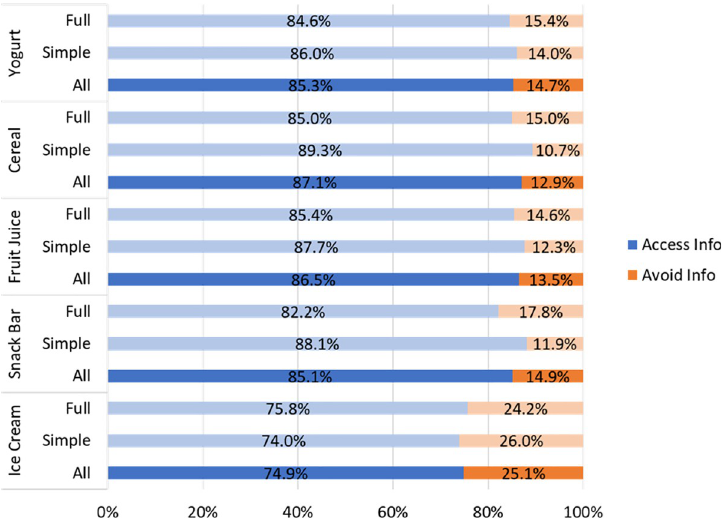
Fig 3. Percentage of added sugars information accessors and avoiders by product category and information treatment (N = 490). https://doi.org/10.1371/journal.pone.0249355.g003 Table 2. Predictors of information avoidance behavior by product category (N =